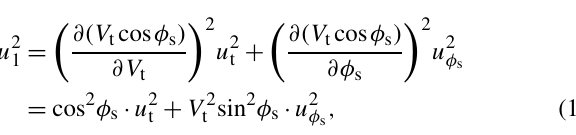
Equation (10) applied to Eq. (7) results in Eq.